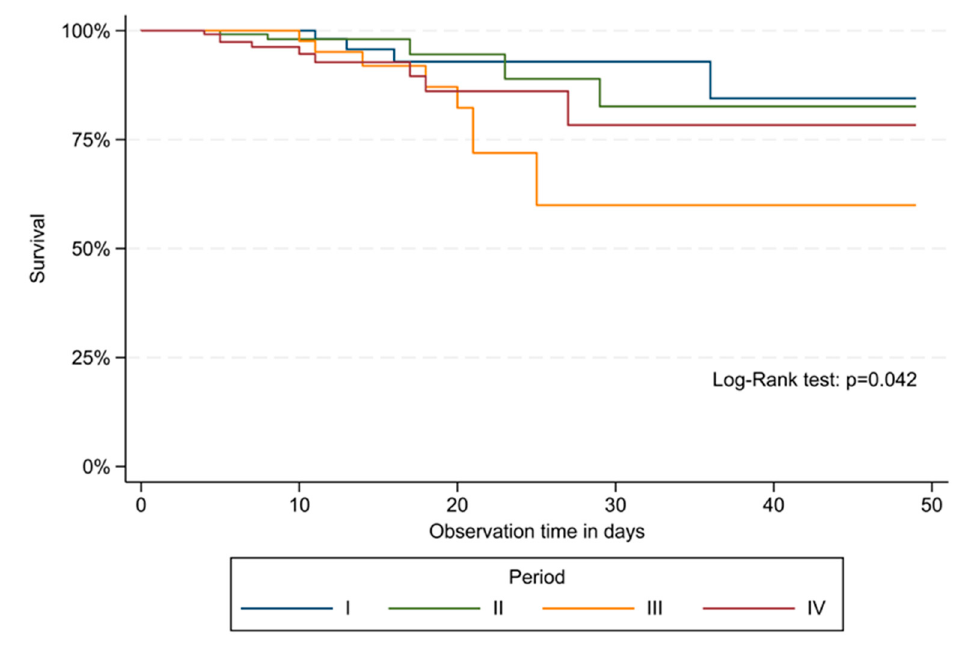
Figure 4. Kaplan–Meier survival estimates for time-to-first healthcare-associated infection (HAI) occurring in patients admitted to the neonatal intensive care unit of Umberto I teaching hospital of Rome between March 2018 and February 2022 by study period. Table 3. Multivariable Cox regression model for first healthcare-associated infection among patients admitted to the neonatal intensive care unit of Umberto I teaching hospital of Rome between March 2018 and February 2022 (N = 503). 95% CI p -Value